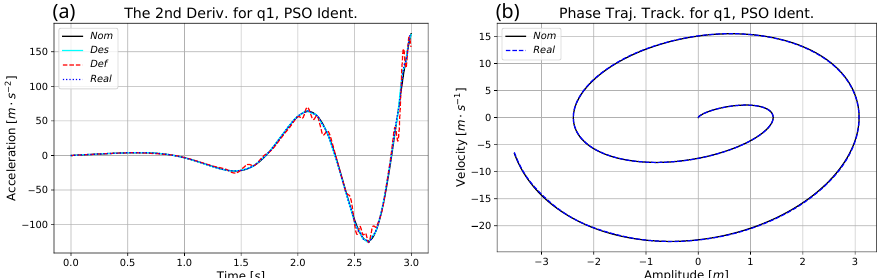
Figure 4. The second time derivatives ( a ) and phase trajectory tracking ( b ) for q 1 .